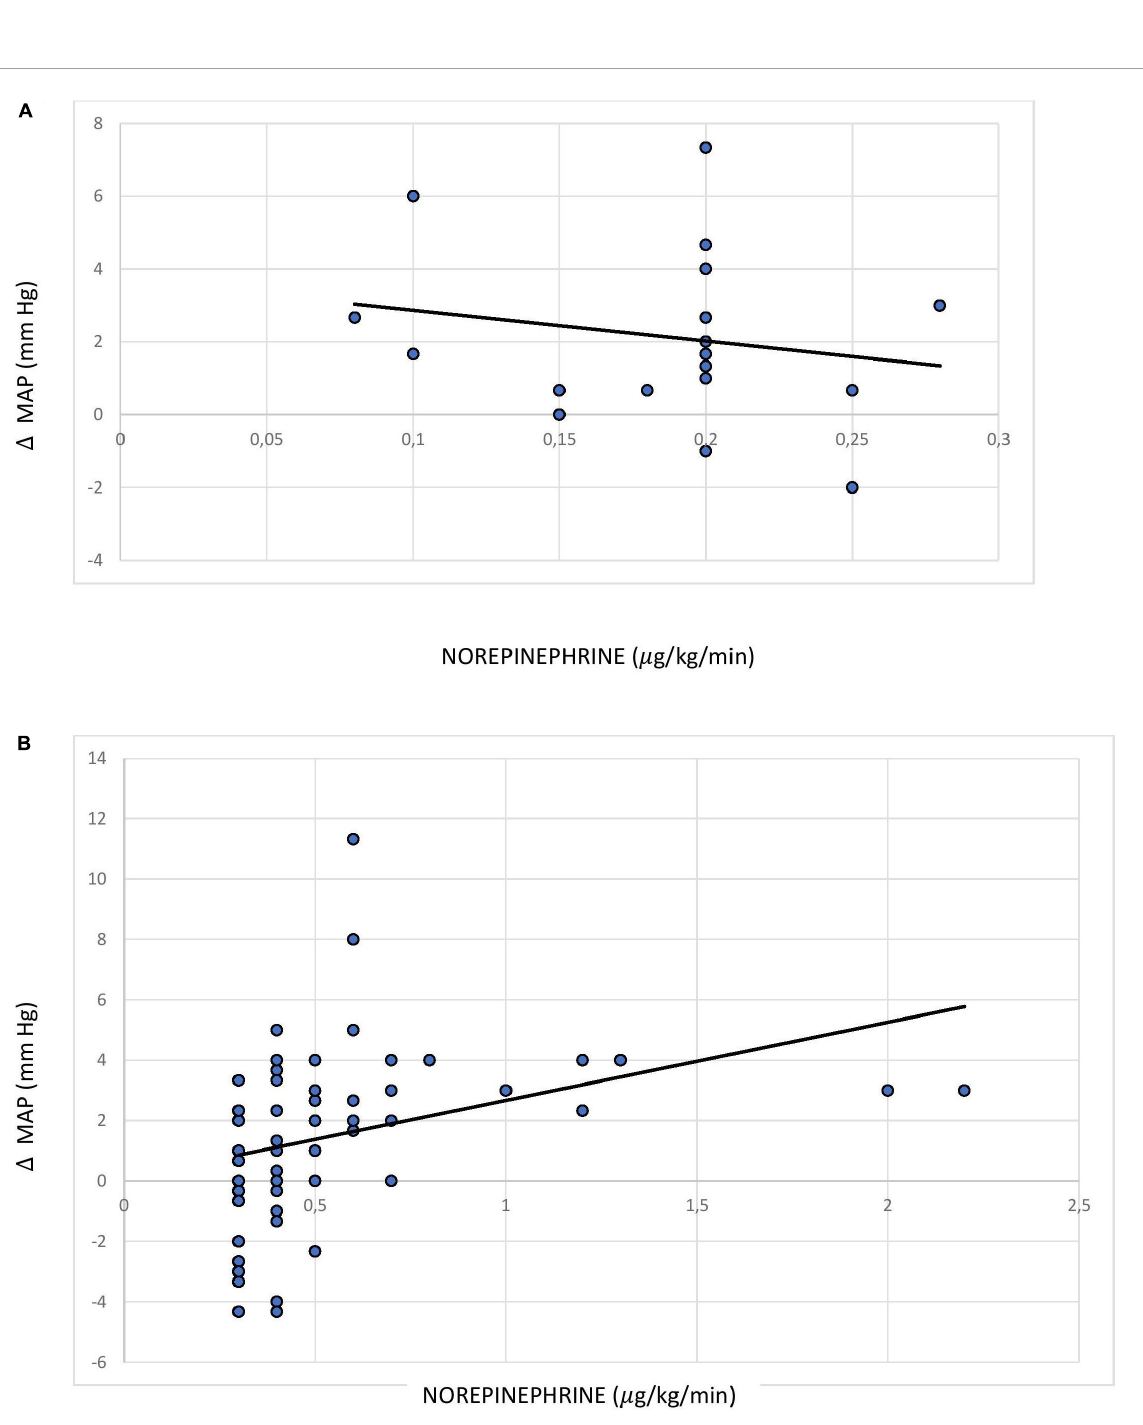
FIGURE3 Pearson correlation between norepinephrine dose and mean arterial pressure difference between the femoral and radial sites among patients receiving (A) norepinephrine dose < 0.3 (0.1–0.29) µ g/kg/min; (B) norepinephrine dose ≥ 0.3 µ g/kg/min.